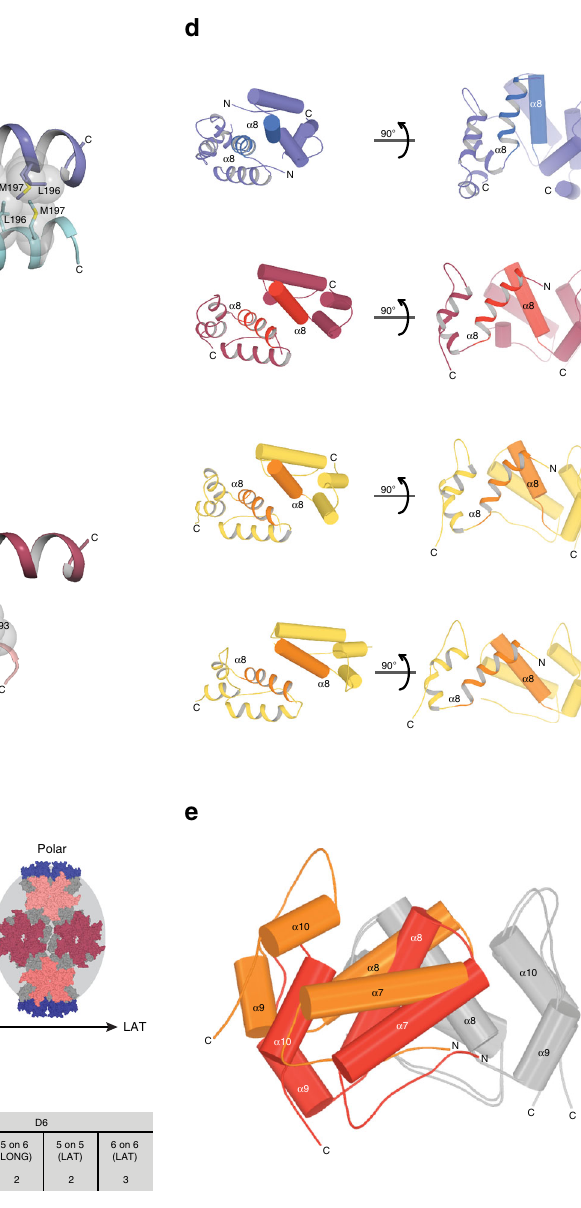
Fig. 7 Analysis of HML2 CA rec CTD – CTD interactions. a , b Structures of the CTD – CTD dimer interface in solution (lowest-energy NMR structure) ( a ) and in the T = 1 particle ( b ) are shown in cartoon representation. Residues involved in the interface are shown as sticks with hydrogen bonds shown as dashes. The boxed region is rotated 90° to show the hydrophobic interactions between helix α 8 of each monomer, with the van der Waals radii shown as grey space fi ll. c Plot of the cross angles and displacements between α 8 helices in all CTD – dimer pairs. The circles are colour-coded with respect to particle type, shown in the key. Groups 1, 2 and 3 are ringed and a schematic describing the nomenclature of POLAR, LONG and LAT is shown alongside. The class of interaction seen in each particle type and the group to which they belong is shown in the key below. d Panel of representative CTD dimers from the groups displayed in c . Top to bottom: NMR dimer (group 1); T = 1 pentamer (group 2); T = 3 pentamer on hexamer (group 2); T = 3 hexamer on hexamer (group 3). e alignment of CTD monomers (grey) showing relative displacement of the interacting CTD monomer in T = 1 (red; group 2) and T = 3 hexamer on hexamer (orange; group